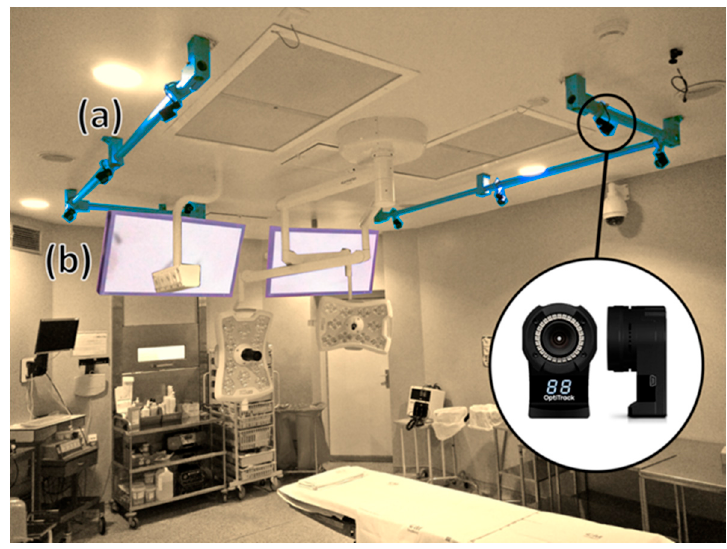
Figure 4. Operating room where surgeries of case 1 and 2 were performed, showing the distribution of the eight optical tracking system cameras in blue ( a ) and two surgical monitors in pink ( b ).